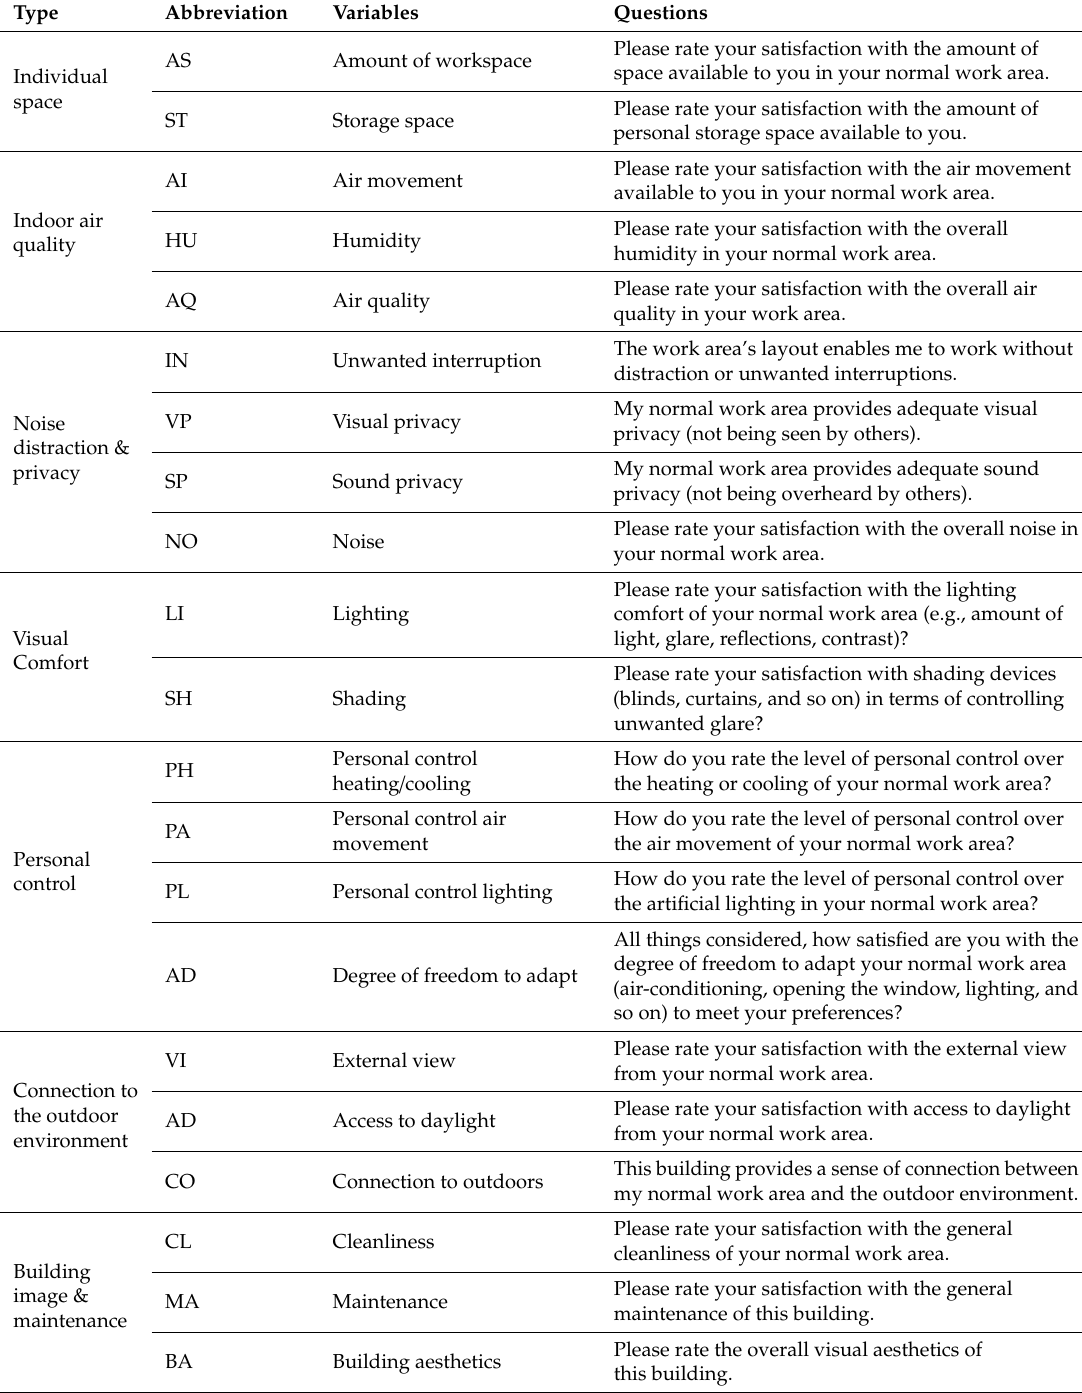
Table 2. This subset features premium spaces, holding certifications from the Green Building Council of Australia (GBCA) and / or WELL Building Standard. O ffi ces are located in buildings that hold a valid rating from the National Australian Built Environment Rating System (NABERS), which is